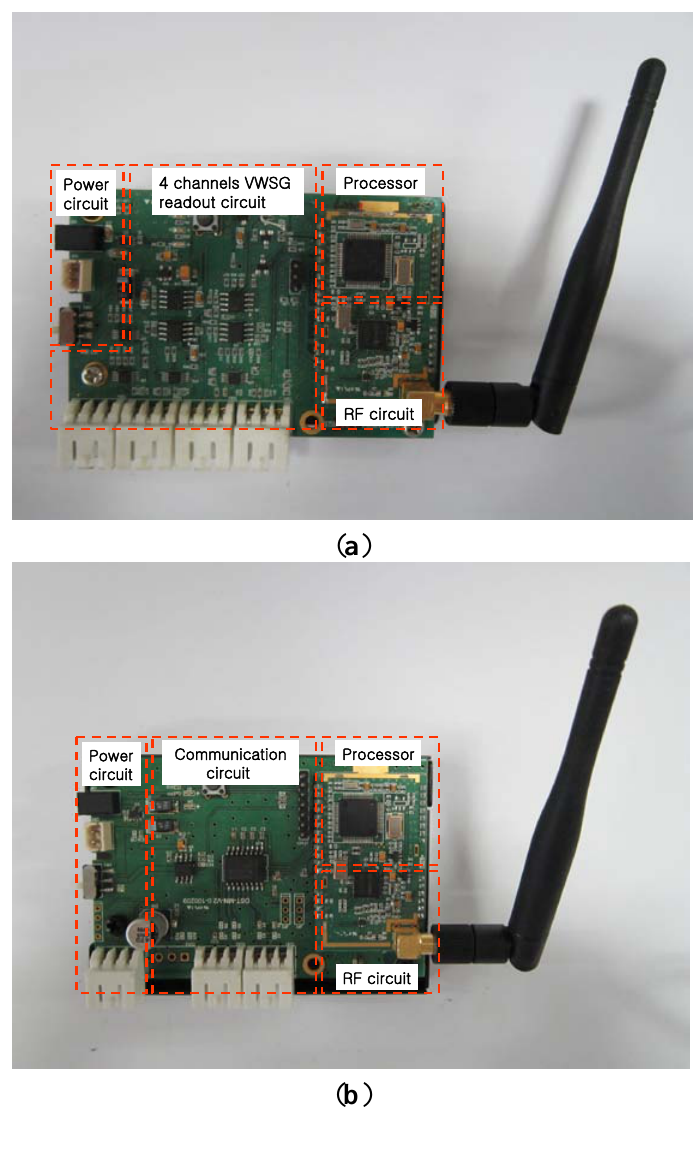
Figure 4. Wireless sensor node and master node. ( a ) Sensor node; ( b ) Master